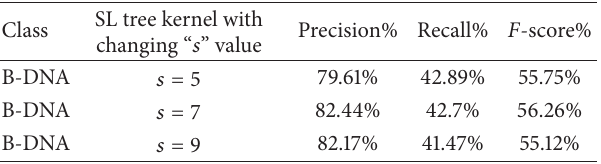
Table 2: Performance of different 𝑠 values of SL kernel on class B- DNA.